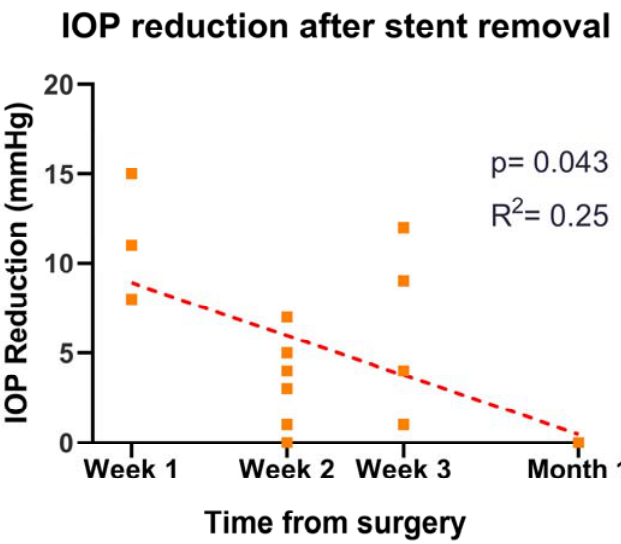
Figure 3. Summary of the relationship between IOP reduction one week after the stent removal and the time of removal. The squares show the IOP reduction in each eye one week after the stent removal. The red dashed line represents the linear regression between IOP reduction and time of removal. IOP: intraocular pressure.